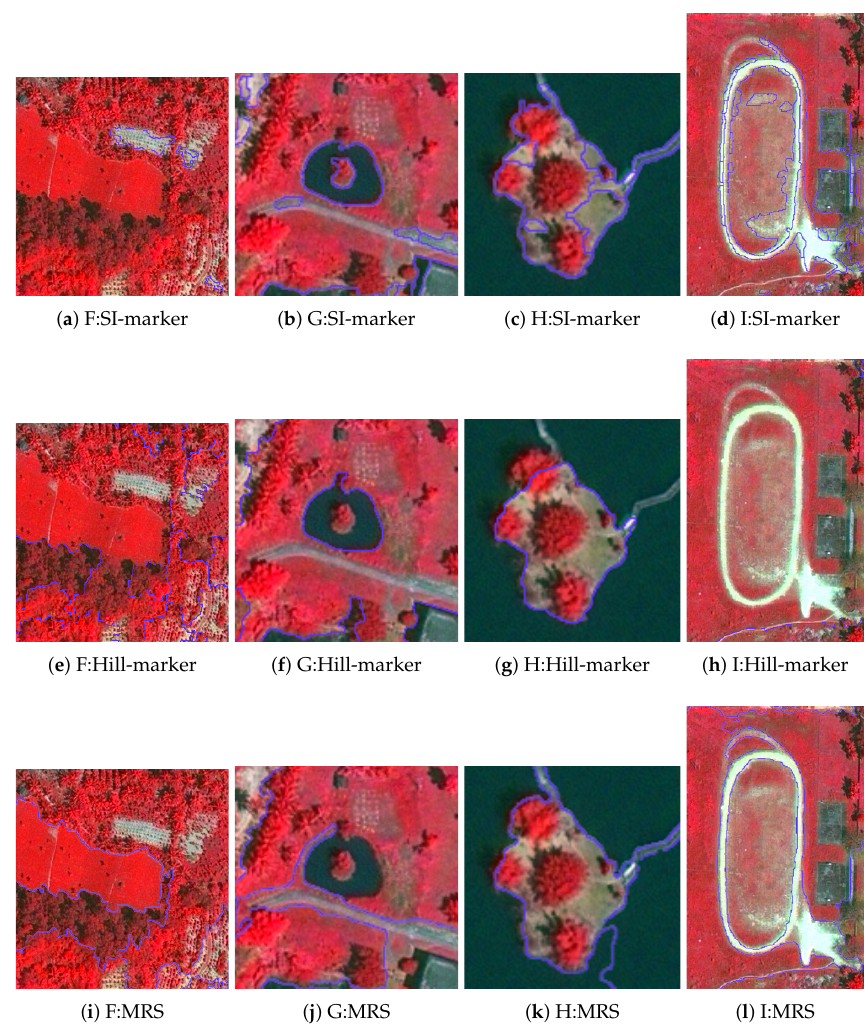
Figure 17. The segmentation result of Regions F, G, H, and I of dataset D2 based on the SI-marker method, the Hill-marker watershed segmentation method, and the MRS